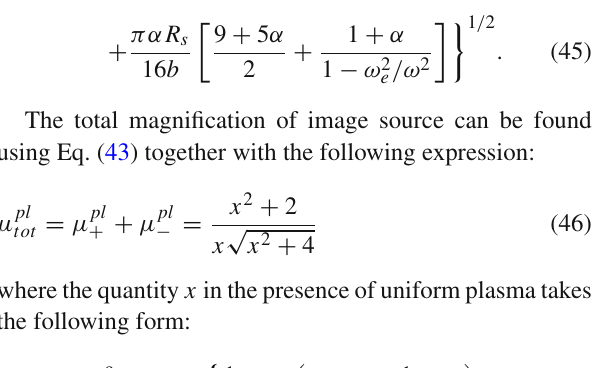
Fig. 5 The dependence of the total magnification μ tot on the MOG parameter for the different values of the plasma frequency at b = 3 M